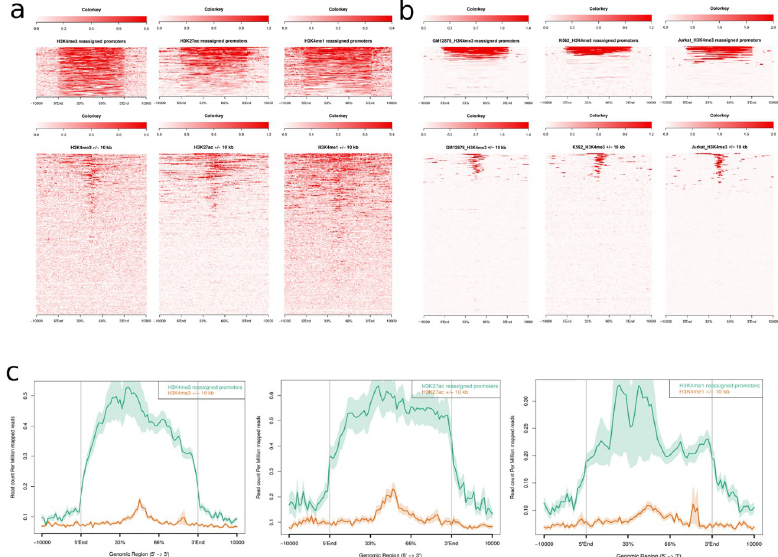
Fig 6. Histone mark ChIP-seq read density plots of candidate t(12;21) active promoters. (a) Heatmaps of H3K4me3, H3K27ac and H3K4me1 ChIP-seq normalized read densities for candidate (bottom, ± 10kb around the 5’ start of vlincRNAs, n = 256) and reassigned (top, n = 79) t(12;21) active vlincRNA promoters. (b) H3K4me3 ChIP-seq normalized read densities in GM12878, K562 and Jurkat cell lines on candidate and reassigned t(12;21) active vlincRNA promoters. (c) ChIP-seq normalized read density plots of the H3K4me3, H3K27ac and H3K4me1 histone marks for candidate and reassigned t(12;21) vlincRNA promoters.